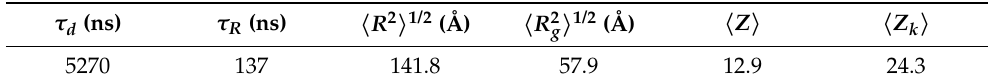
Table 1. Quiescent properties of the simulated C 1000 H 2002 melt. τ d is the disengagement time, τ R is 1/2 is the average chain end-to-end distance, R 2 the Rouse time, (cid:104) (cid:105) Z of gyration, is the average number of entanglements per chain, and (cid:104) (cid:105) of kinks per